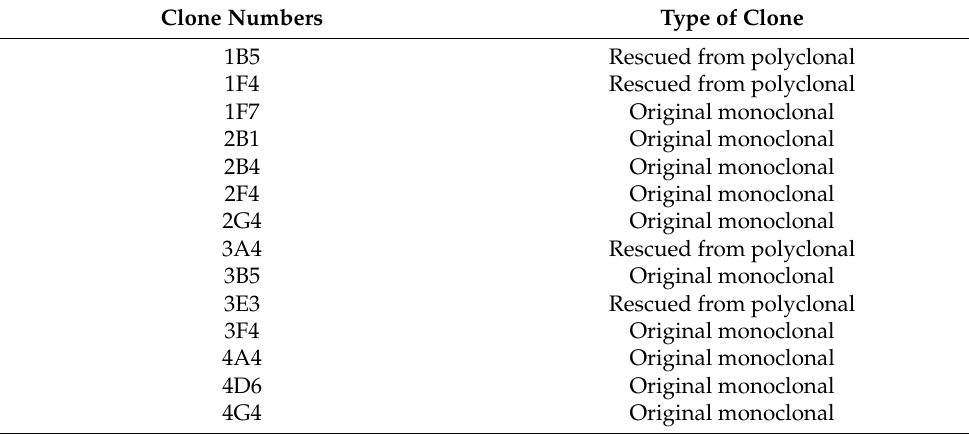
Table 2. Different monoclonal N2C-pTet-TurboFP635-EF-1a-eGFP cell